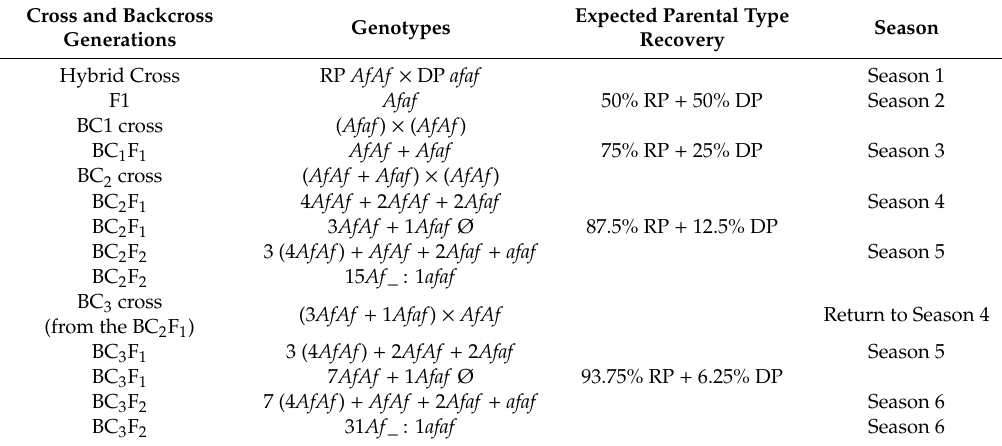
Table 1. Abbreviated method for backcrossing the homozygous recessive afila gene (genotype afaf ) into commercial varieties with normal leaflets (genotype AfAf ).